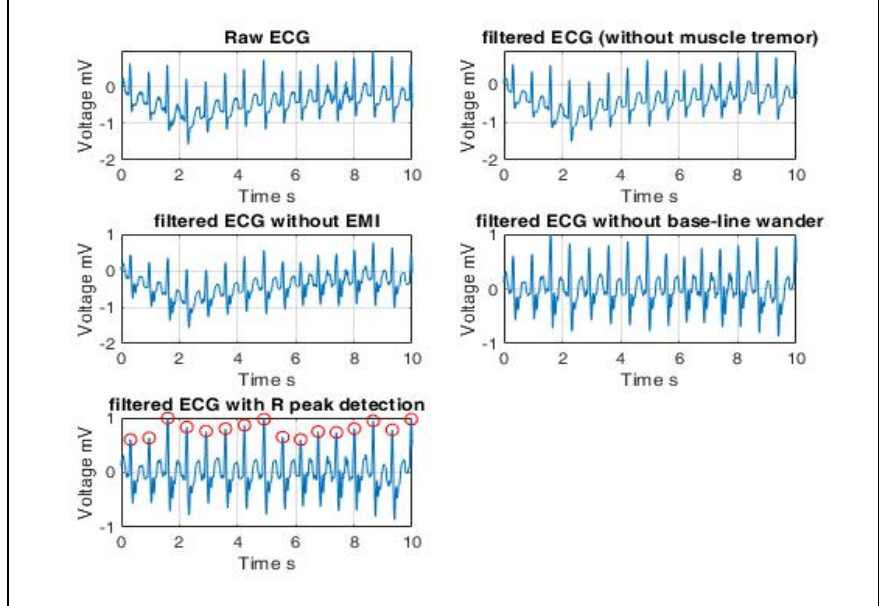
Figure 7. ECG signal pre-processing (left to right): ECG signals are extracted using electrodes mounted on the body. Hence, some artifacts are filtered out before statistical features can be ex- tracted from the ECG signal database. Artifacts include muscle tremor, electromagnetic interference (EMI) and base-line wander. Muscle tremor artifacts caused due to sudden body movements are high-frequency signals (30~300 Hz) that are removed by Butterworth low-pass filters. The 50 Hz electromagnetic interference is suppressed by a Butterworth band-stop filter. Baseline wander is an ultra-low frequency signal that ranges between 0 and 0.8 Hz that can be eliminated using a high- pass filter. Finally, the resultant R peaks of a QRS complex are detected, and only RR interval-based features are extracted since the radar-generated heartbeat phase signals are QRS equivalent signals. Table 2. Model architecture where Kfold = 5, random seed = 42, loss function = MSE, optimizer = Levenberg–Marquardt algorithm, momentum = enabled, early stopping = 10 rounds, autotuning objective function = MSE, autotuning algorithm: grid search, BatchNorm = disabled.